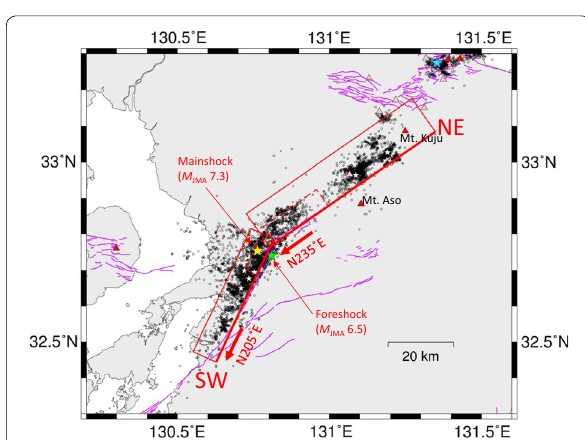
Fig. 5 Map of the Futagawa and Hinagu fault planes. The solid red rectangles show the areas of the planes used in Fig. 6 projected onto the surface, and the red dashed rectangles indicate the source fault planes of the mainshock and foreshocks estimated by Kato et al. (2016) and GSI (2016). Active faults (Nakata and Imaizumi 2002) are plotted by the purple lines . Black circles denote the events ( M JMA that occurred for 1 month following the foreshock. See the caption of Fig. 1 for explanation of the star and triangle